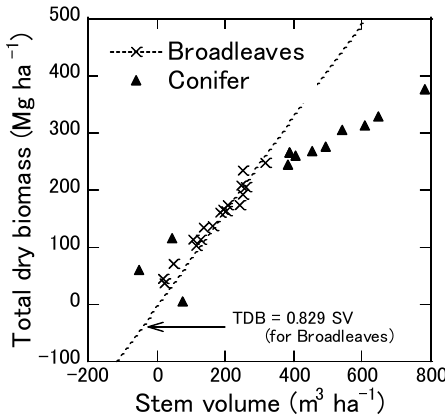
Figure 10. Comparison of predicted SV and TDB at validation plots.